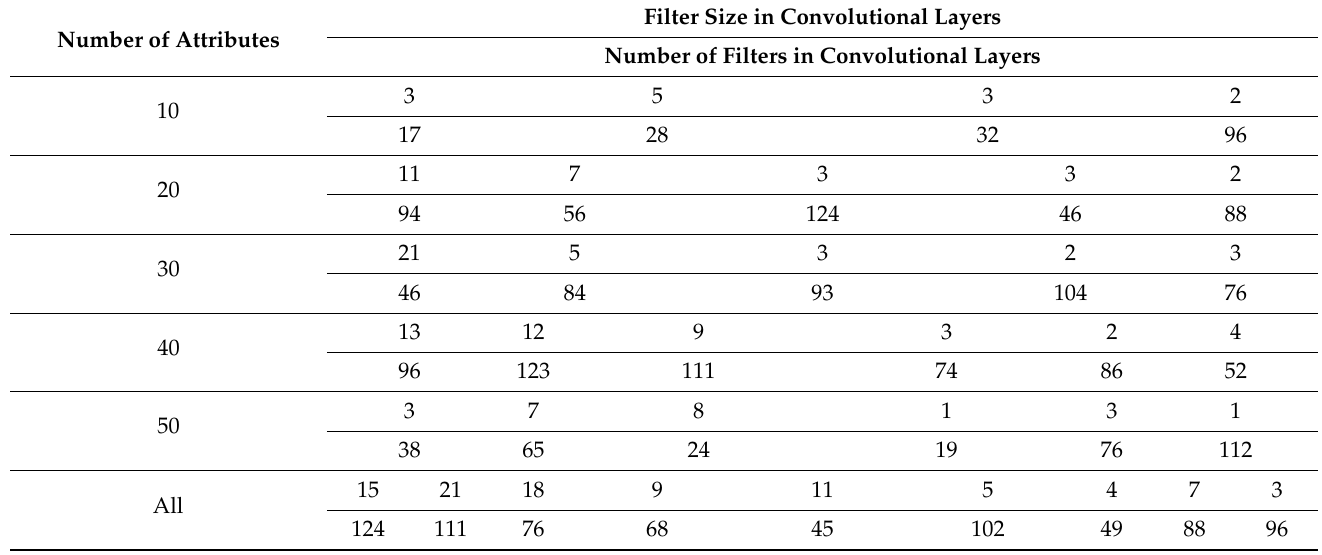
Table 3. Filter parameters of each convolutional layer for cancer prediction. (Illustrations by the authors).